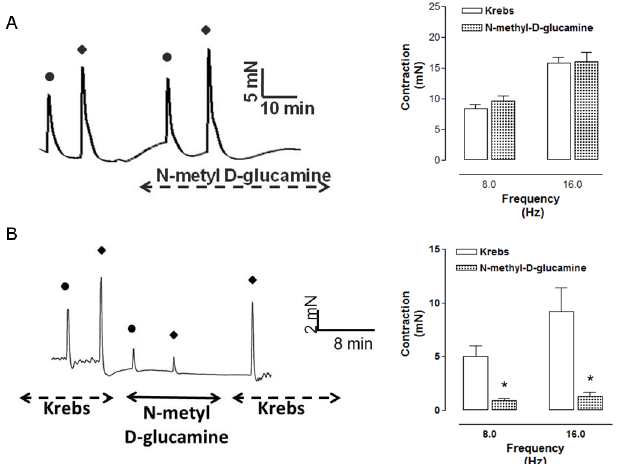
Fig 6. Representative illustrationof EFS-induced contractionof Crotalus (A) and rabbit (B) corpora cavernosain the presenceof Kreb’s modifiedsolution(equimolarsubstitutionof sodium chlorideby N– methyl–D-glucamine) (NMDG).